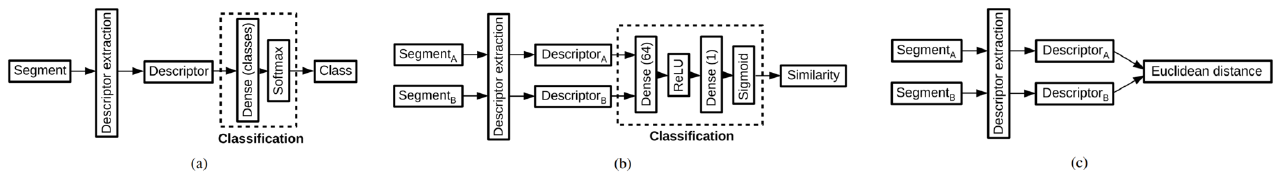
Figure 33. Three network structures [86] ( a ) group based CNN ( b ) Siamese CNN, and ( c ) descriptor extraction CNN trained using contrastive